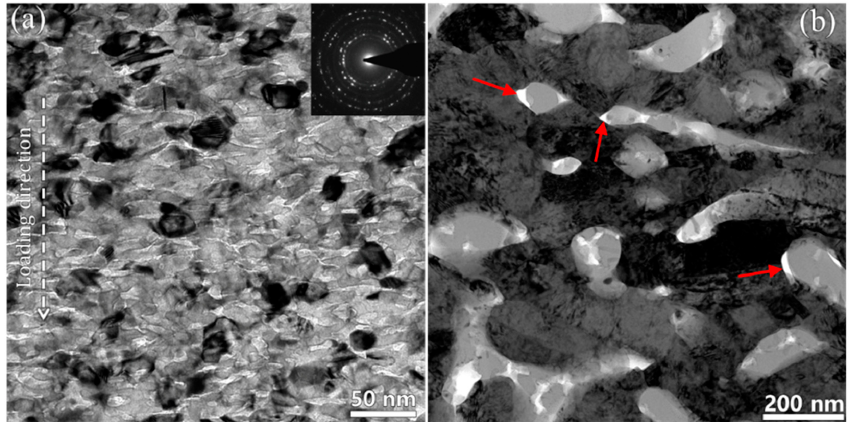
Figure 14. Post mortem TEM characterization of ( a ) 600 °C annealed and ( b ) 800 °C annealed Ni(75 at.%)-SiOC nanocomposites after compression tests [60]. The red arrows in ( b ) indicate interface decohesion between crystal Ni and amorphous SiOC ceramic.